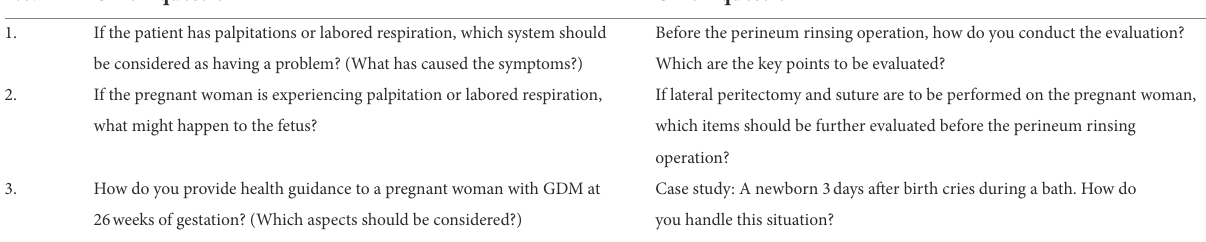
TABLE 2 Open-ended